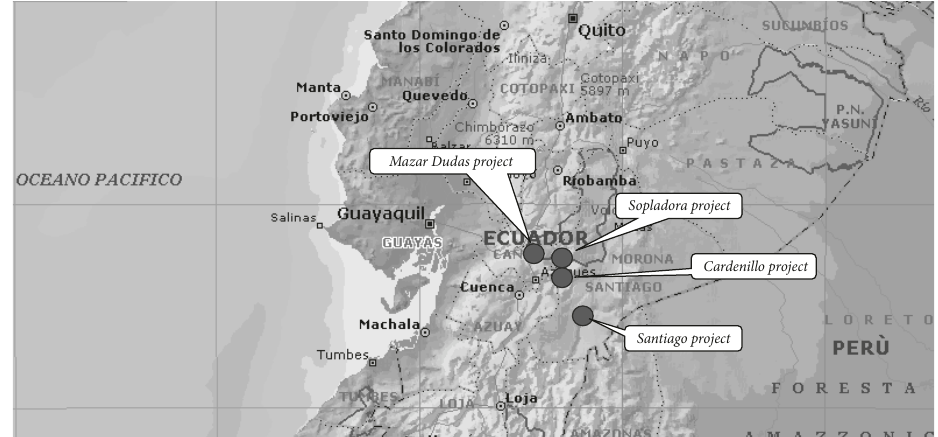
Figure 3: Geographical location of hydroelectric projects in the Republic of Ecuador, prepared from [36].